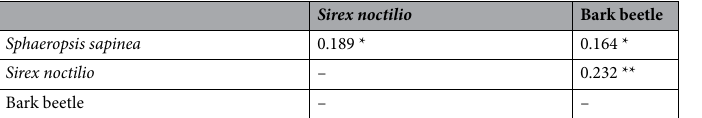
Table 1. Phi (φ) coefficients for within-tree associations for S. sapinea and Boring pests. * P < 0.05; ** P < 0.01; *** P < 0.001.